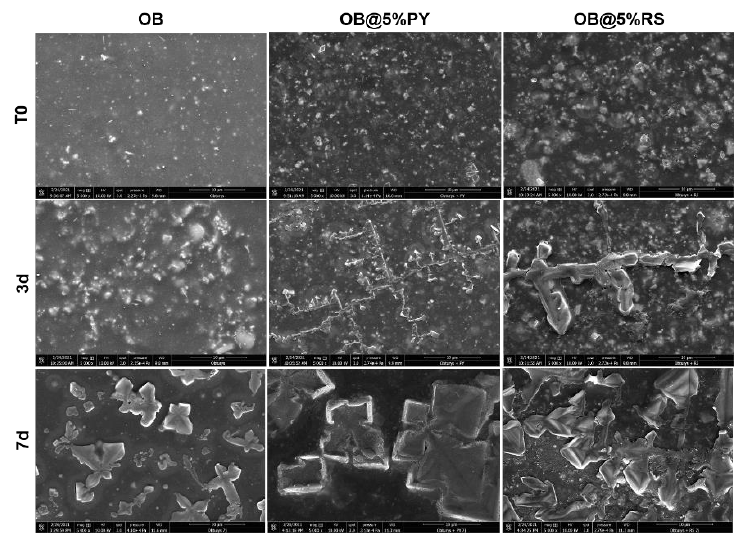
Figure 6. Representative scanning electron microscopy images at 5000× magnification. The mor- phologies of OB, OB@5%RS and OB@5%PY surfaces were analyzed in dry condition (T0); and after 3 and 7 days in PBS at 37 °C.